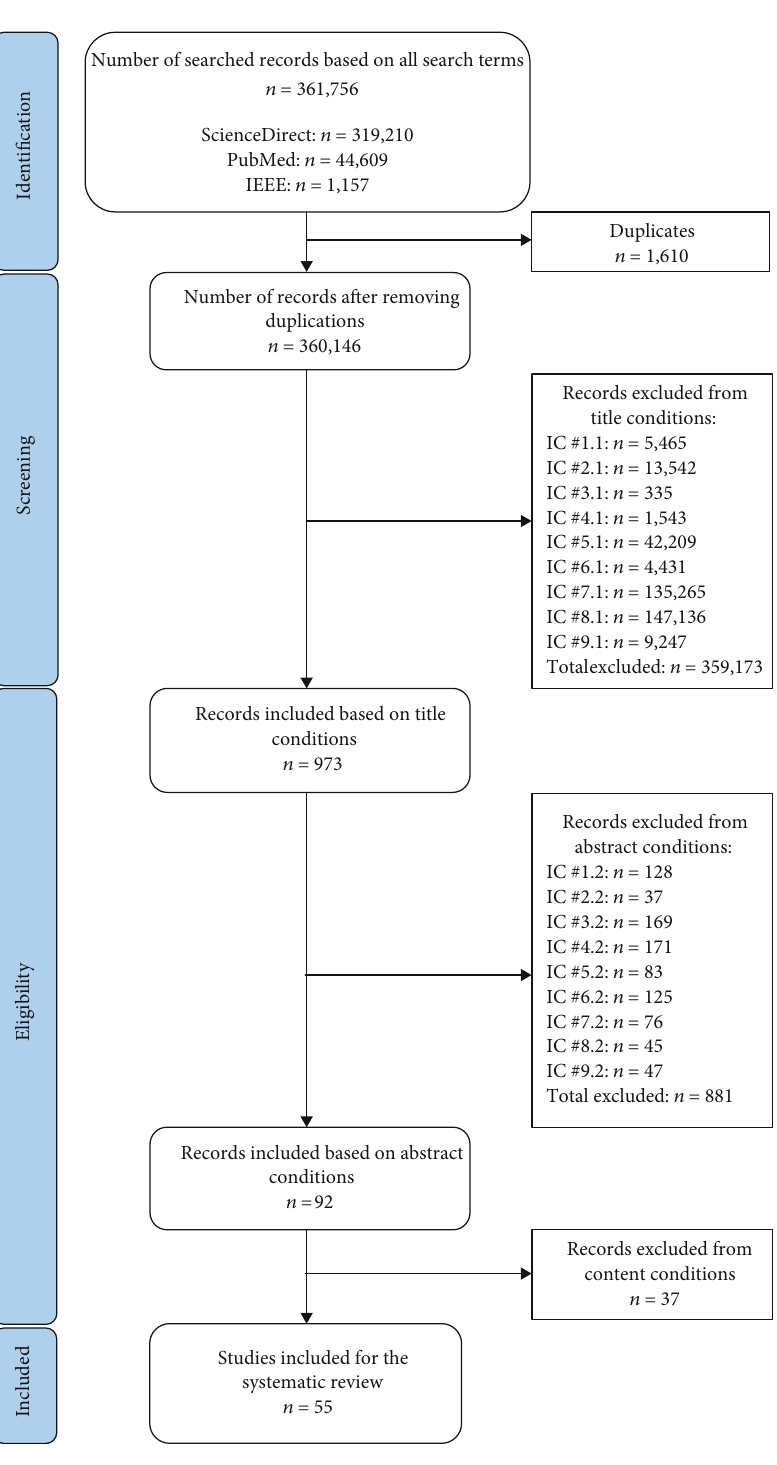
Figure 1: Work fl ow of the selection process using PRISMA protocol for the performed systematic